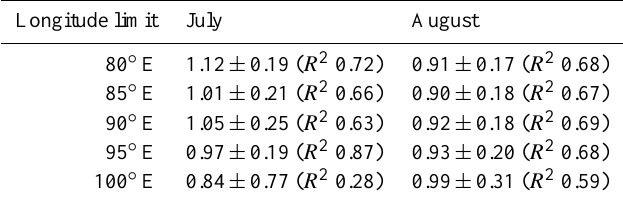
Table 3. Slopes of the correlation of NMHC photochemical ages and FLEXPART trajectory transport times for different assumed source regions. The squared Pearson correlation coefficients ( R 2 ) are shown in parentheses (see Sect. 3.3.2 for details).